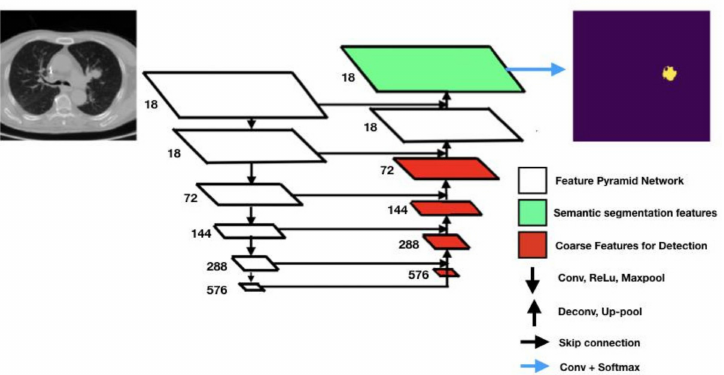
Figure 2. Architecture of the U-Net neural network used to segment lung nodules in CT scans. The number left on each layer represents the number of output